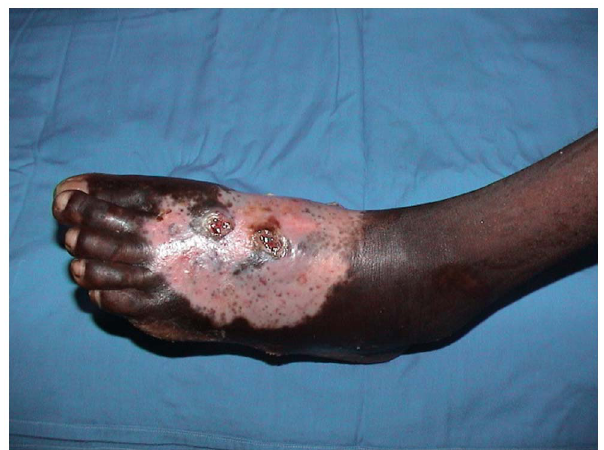
Figure 1. Showing massive foot mycetoma with skin burn following herb treatment.